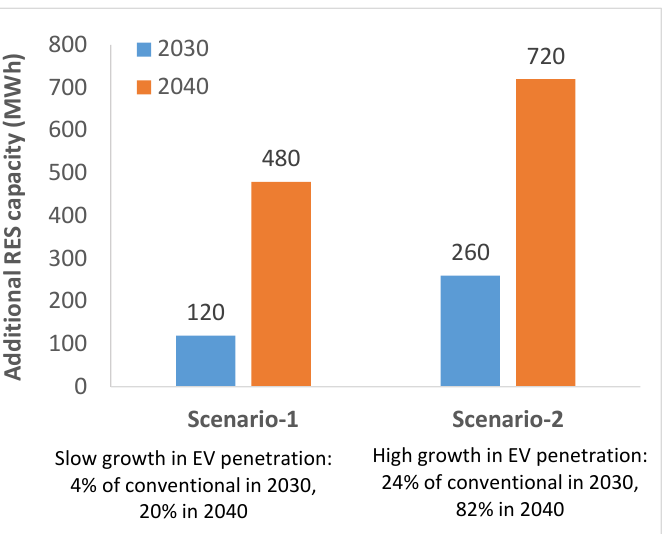
Figure 11. Increase in RES hosting capacity in the Greek islands with the application of V2G meth- odologies [ Error! Reference source not found. ].